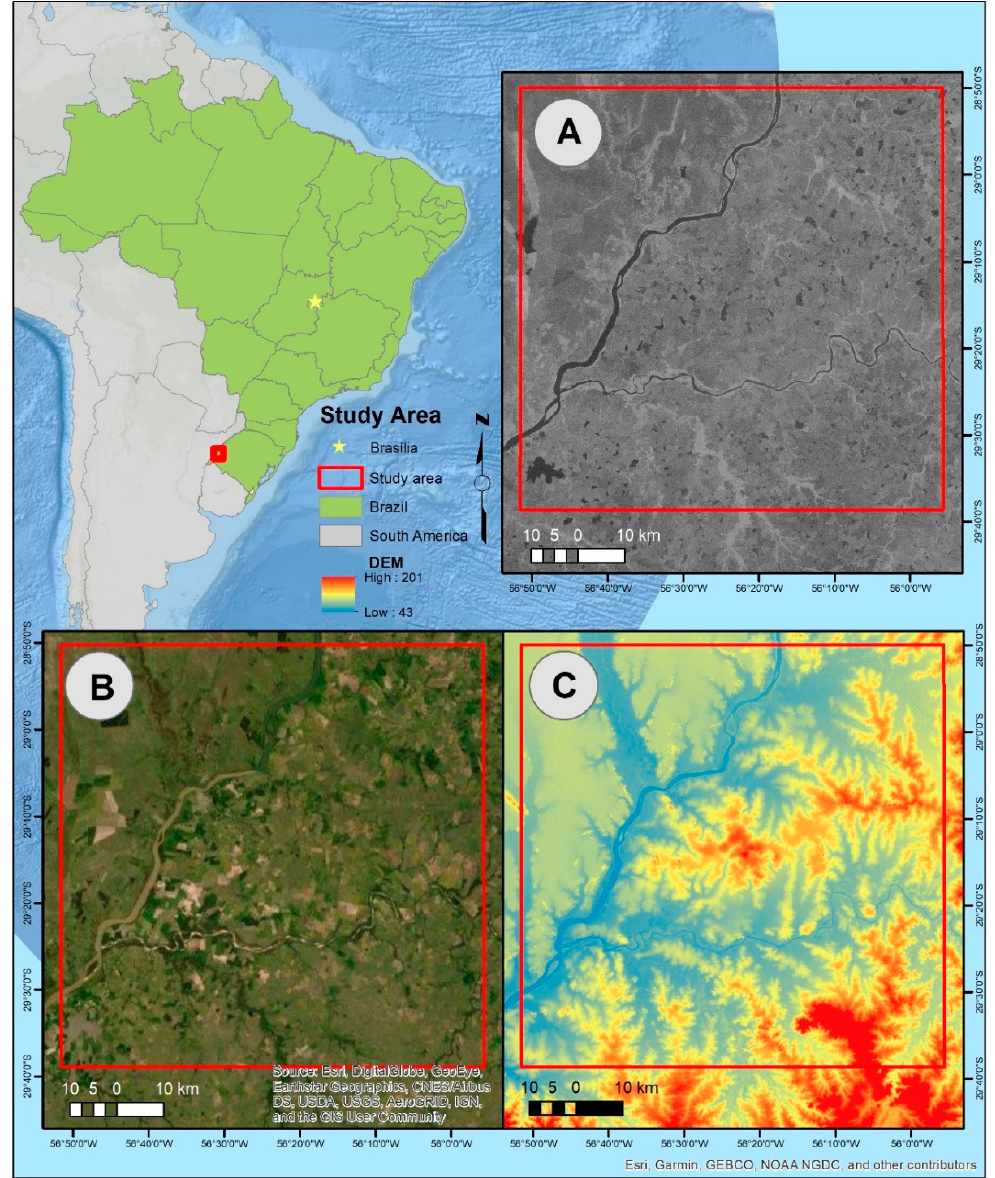
Figure 1. Location map of study area. ( A ) vertical transmit and horizontal receive (VH) polarized synthetic aperture radar (SAR) image (Sentinel-1), ( B ) Operational Land Imager (OLI)-Landsat 8 image, and ( C ) Shuttle Radar Topography Mission (SRTM) data.